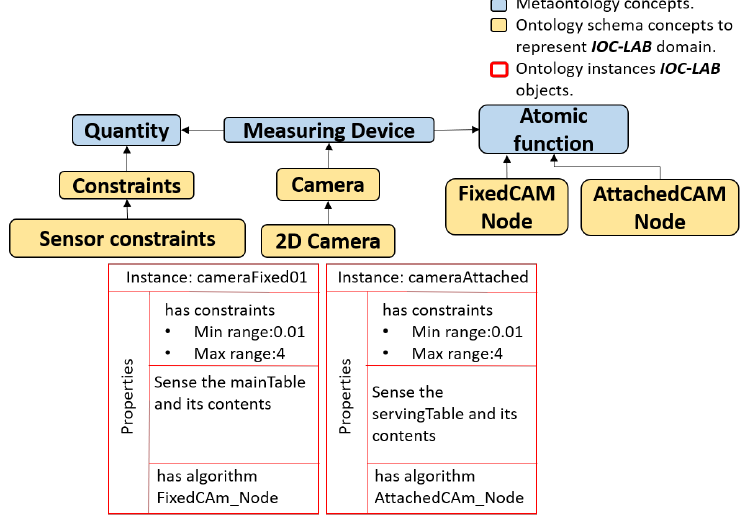
Figure 9. Taxonomy representation of sensor class and its relation in PMK framework. The Quantity and Atomic Function describe the sensor constraints and the labeled running algorithm of each sensor, as shown in the properties part, and inherit from Feature and Action classes,